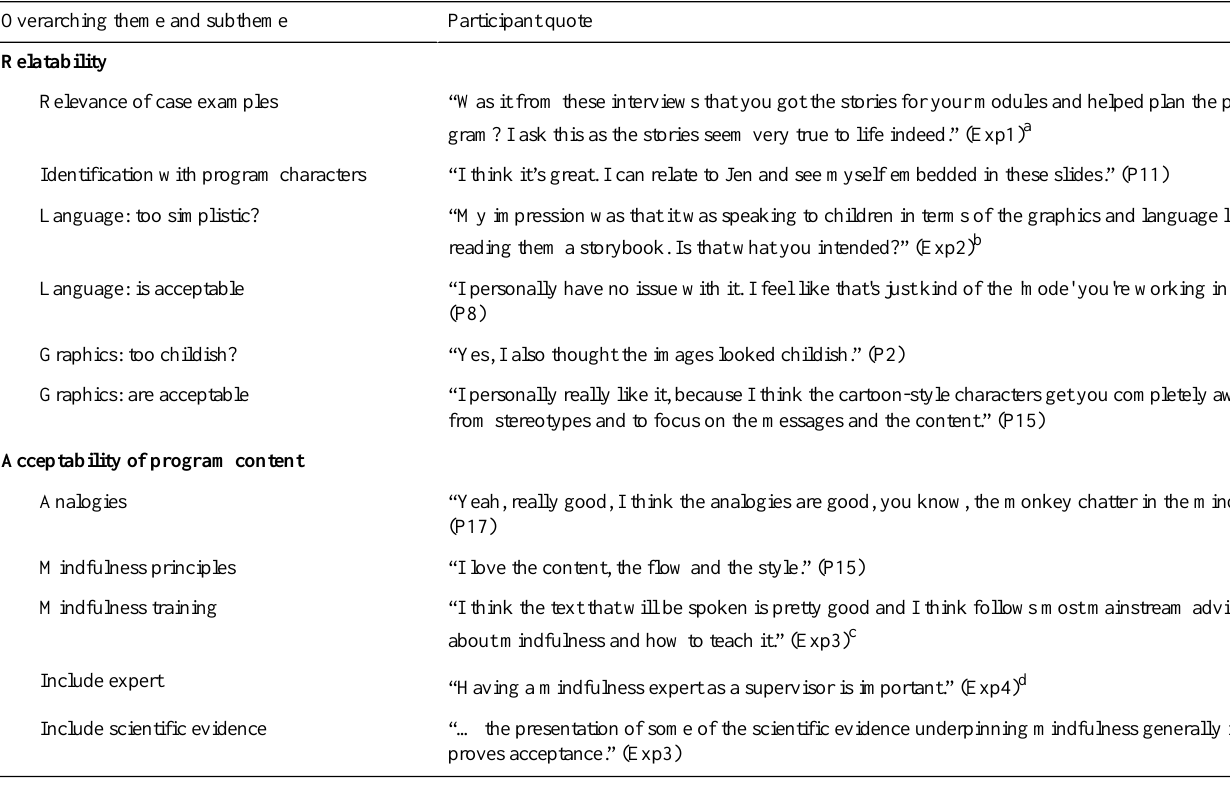
Table 5. Part 3: Iterative feedback from people with multiple sclerosis and experts in the field.